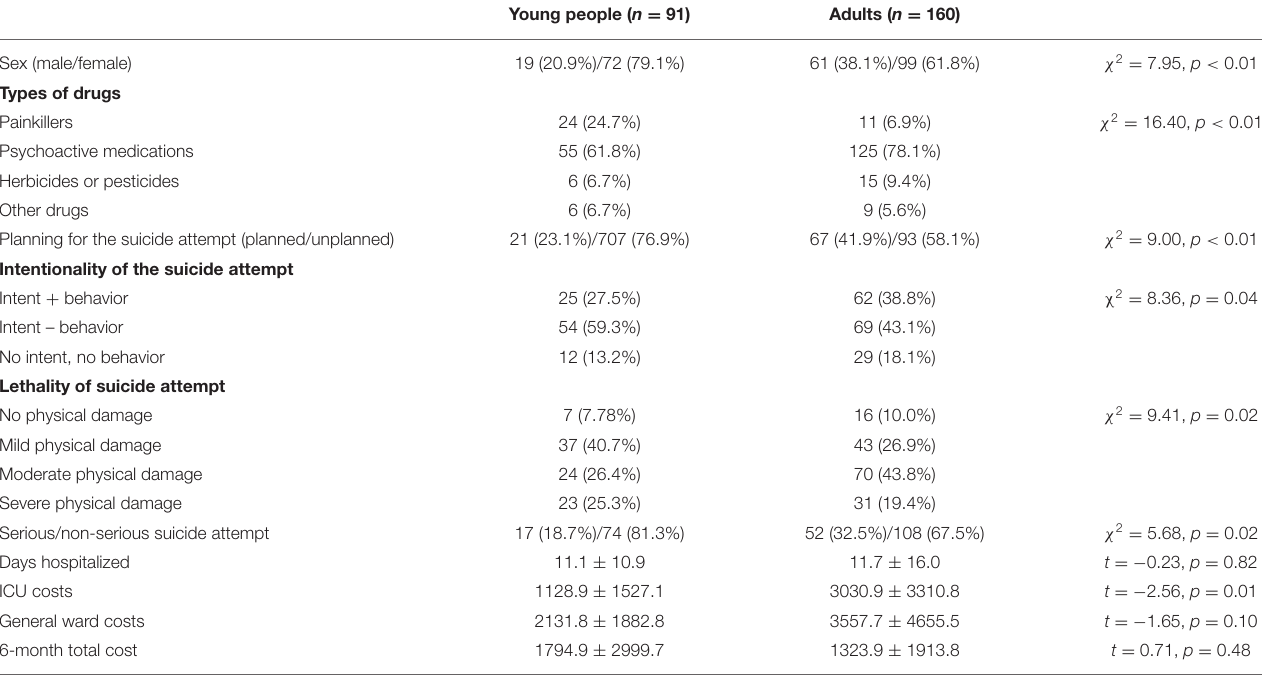
TABLE 3 | Comparison of suicidal patterns and hospital costs between the young people and adult groups.